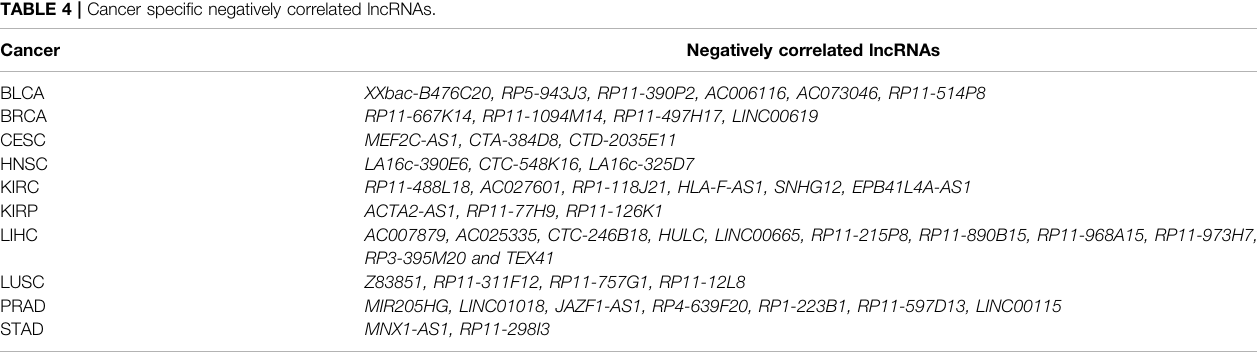
TABLE 4 | Cancer speci fi c negatively correlated